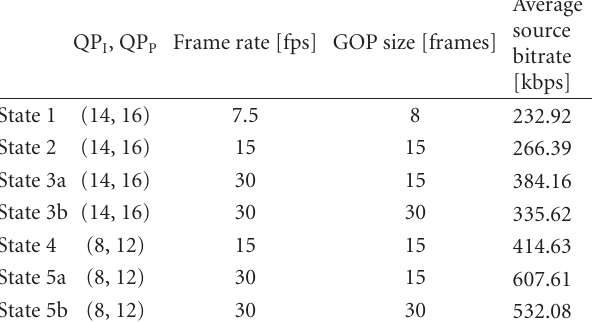
Table 1: Example state sets for joint